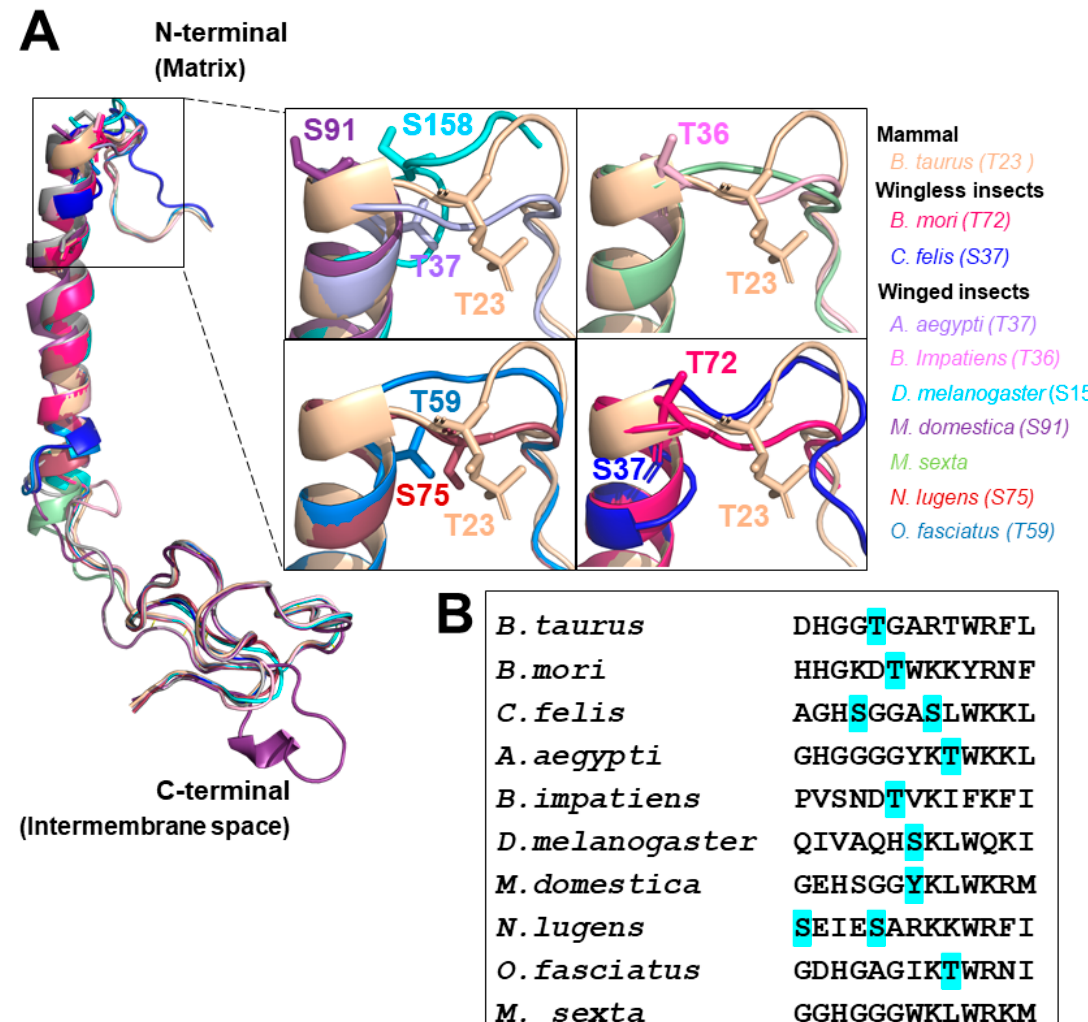
Figure 3. The tridimensional structure models of insect COXVIa: ( A ) overlay of nine structure models of insects COXVIa modeled in the Phyre 2 server using the primary sequence as input, normal modeling mode and the B. taurus crystal structures (PDB 1V54 or 3WG7) as templates [171]. All structures were aligned from the mitochondrial matrix N-terminal on the top to the C-terminal at the intermembrane space at the bottom. The structure models were analyzed using Pymol software and colored as shown in the figure. The positional conservation of the Ser and Thr residues at the beginning of a transmembrane helix is highlighted and shown in the inset boxes. ( B ) Primary sequence alignment fragment representing the beginning of COXVIa transmembrane helix. The highlighted Ser, Thr, and Tyr residues represent the NetPhos predicted P-sites.